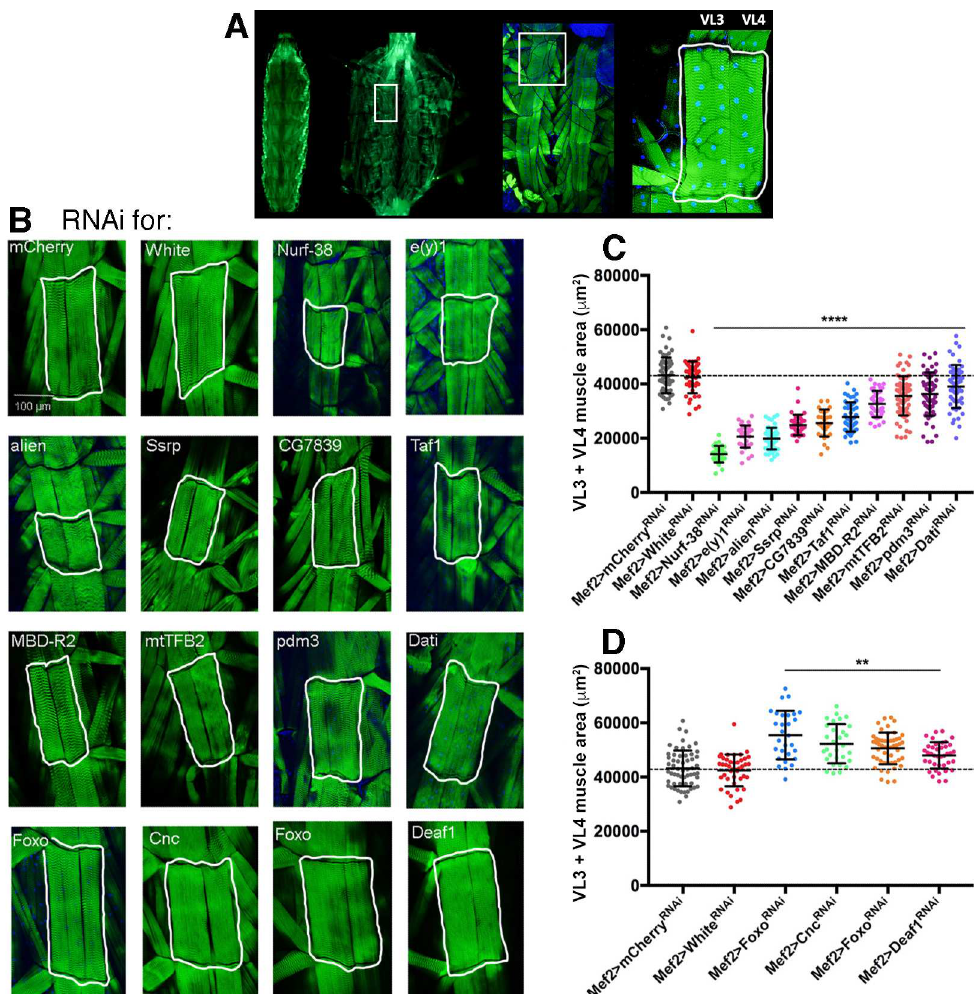
Fig 2. Muscle-specific RNAi for screen hits identifies transcription factors that modulate developmental myofiber growth in Drosophila . (A) Validation of RNAi screen hits via dissection of 3 rd instar larvae and confocal imaging of ventral longitudinal VL3 and VL4 body wall skeletal muscles, which have stereotypical sizes. (B) Compared to controls (white RNAi and mcherry RNAi ), RNAi for screen hits driven in skeletal muscle by Mef2-Gal4 leads to a decrease (atrophy) and an increase (hypertrophy) in the size of VL3 and VL4 skeletal muscles, each consisting of a single myofiber. (C) Quantitation of the cumulative area of VL3 and VL4 muscles from multiple larvae indicates that RNAi for Nurf-38, e(y)1, alien, CG7839, Taf1, MBD-R2, mtTFB2, pdm3, and Dati reduces VL3+VL4 muscle area (atrophy). This indicates that these transcription factors are necessary for optimal myofiber growth during larval development. (D) Conversely, muscle- specific RNAi for Foxo, Cnc, and Deaf1 increases the area of VL3+VL4 muscles (hypertrophy), indicating that these transcription factors limit developmental myofiber growth. N = 12–70 and mean ± SD is shown; �� P < 0.01, ��� P <